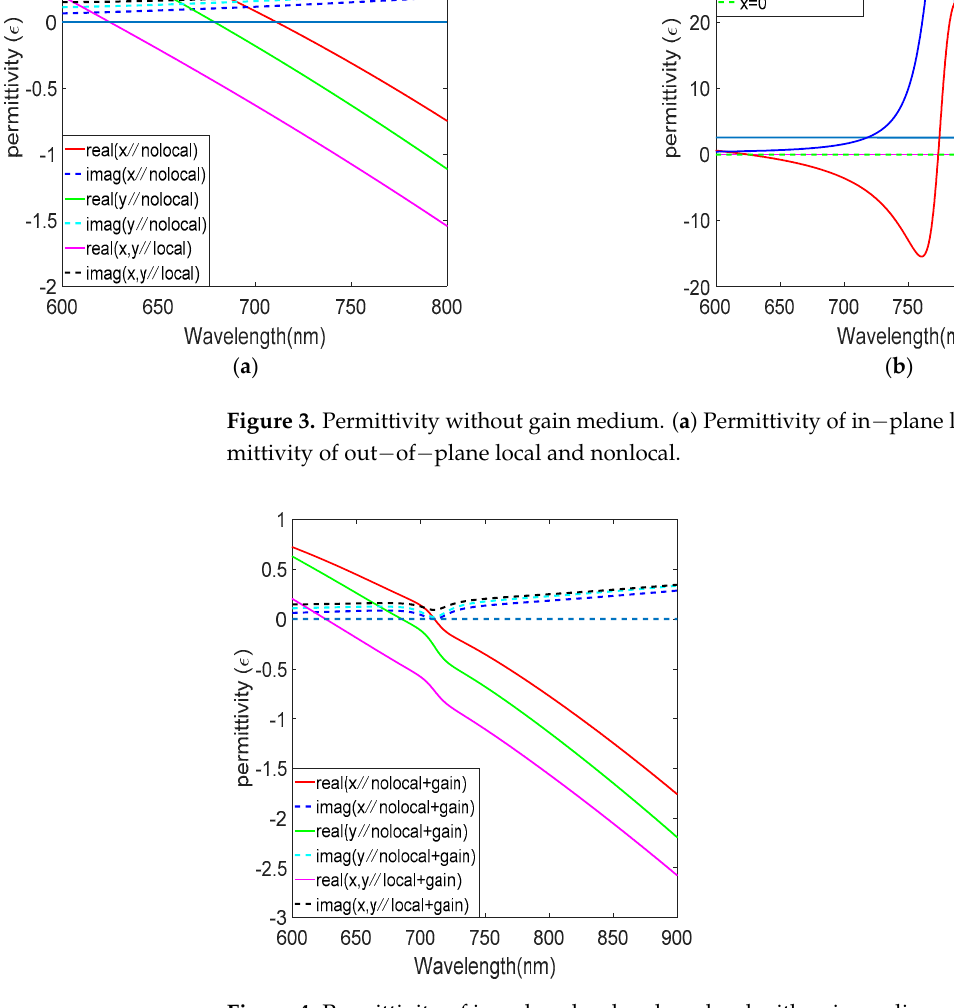
Figure 4. Permittivity of in − plane local and nonlocal with gain medium.